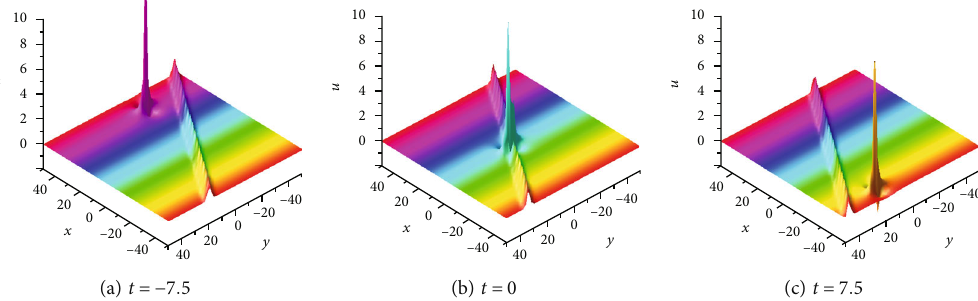
Figure 8: 2-Soliton solution and 1-breather solution ð k η ð 0 Þ = η ð 0 Þ = 0 Þ . 3 4